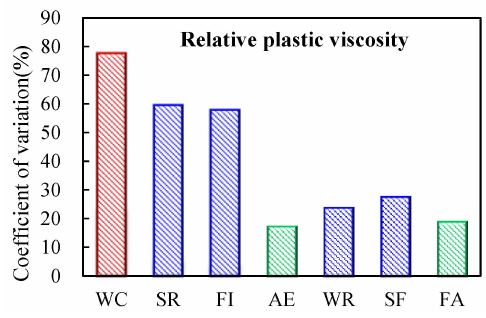
Figure 20. Difference analysis on